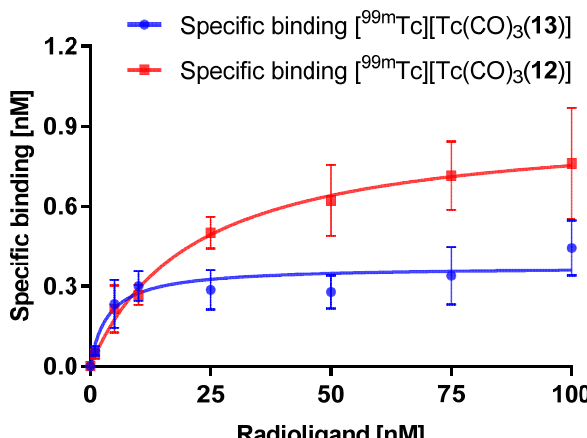
Figure 3. Results of receptor saturation experiments with radiolabeled bombesin (BBN) derivatives [ 99m Tc][Tc(CO) 3 ( 12 )] and [ 99m Tc][Tc(CO) 3 ( 13 )] using GRPR expressing PC-3 cells. K d and B max values were determined by nonlinear regression using GraphPad Prism 7. Data are the mean ± SD ( n = 2–3 in triplicate) and normalized to 10 6 cells per well.